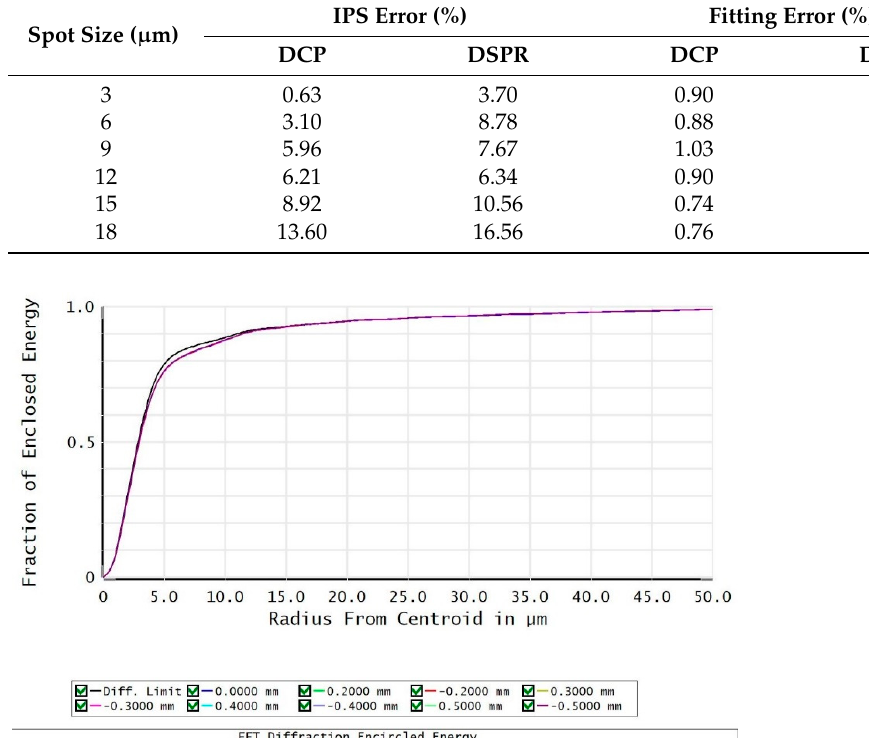
( b ) Figure 7. Calculated IPS of target pixel in the short-wave infrared FPA photodetector: ( a ) calculated IPS based on the DCP model; ( b ) calculated IPS based on the DSPR model. In order to evaluate the performance of the DCP model for the IPS characterization of the experimental data, the beam spot scanning response map of experiment and the fitting value of DCP model in target pixel are plotted in Figure 8a. The fitting error of the DCP model for the target pixel is 4.29%. Then, in order to compare the proposed improved DCP model with the DSPR model, we also calculated the IPS of the target pixel based on the DSPR model, which is shown in Figure 7b. It can be seen that there exist some fluctuations for the calculated IPS re- sponse in adjacent pixels based on the DSPR model, which is mainly caused by the noise of the experimental measurement. Therefore, we found that the DCP model is less affected by noise than the DSPR model. The beam spot scanning response fitting value of DSPR model was also calculated, which is shown in Figure 8b. It can be seen that the fitting value of DCP model is closer to the experimental scanning value than the fitting value of